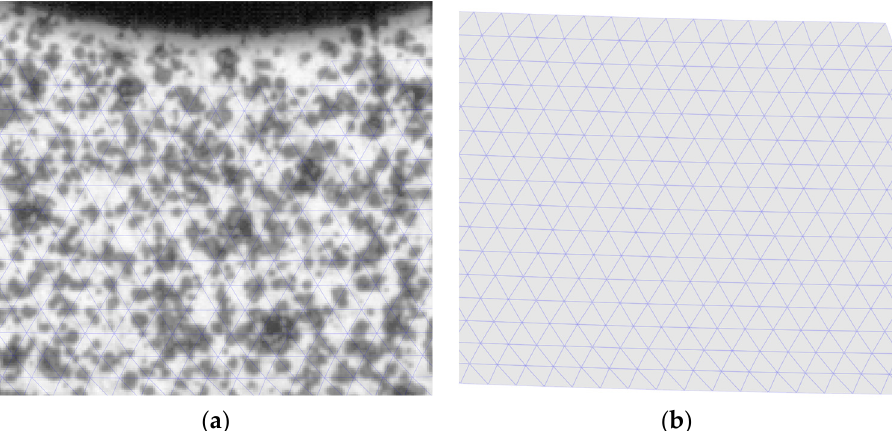
Figure 2. The measuring plan setup with span length.